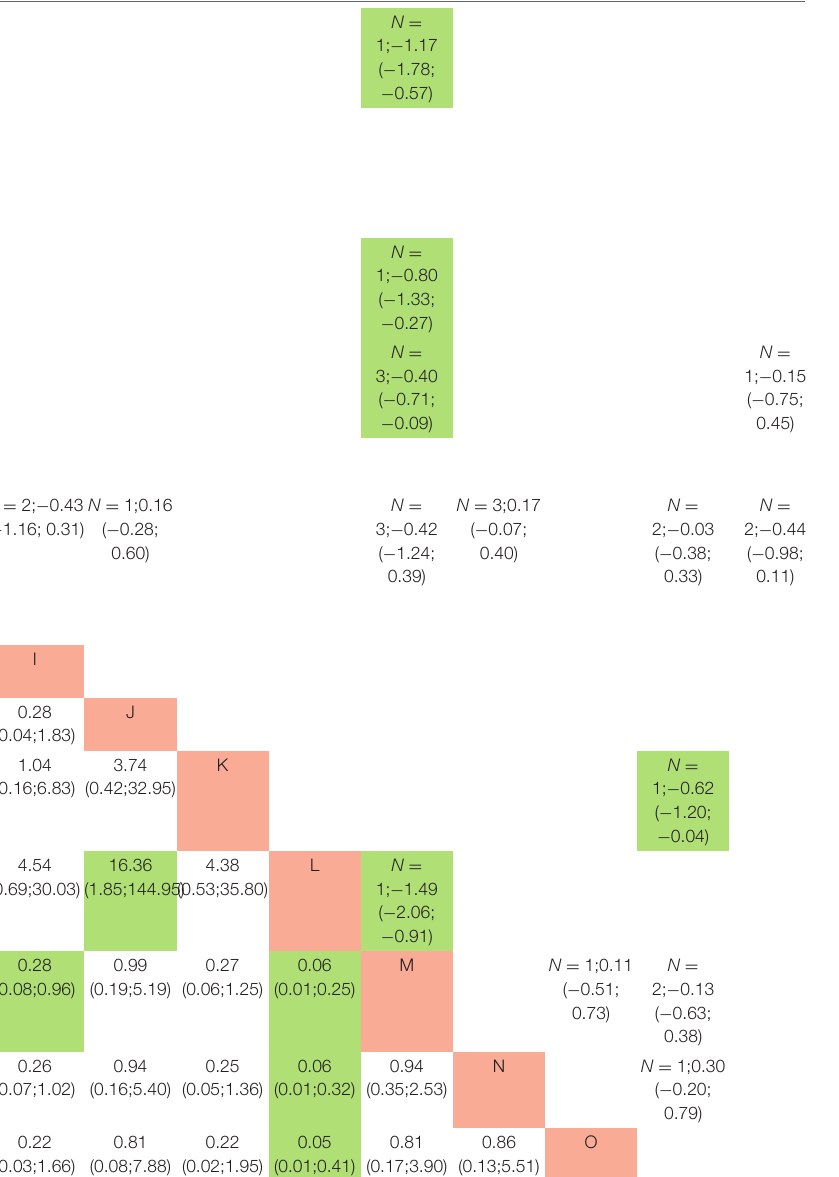
TABLE 6 | Results of treatment comparisons for postoperative